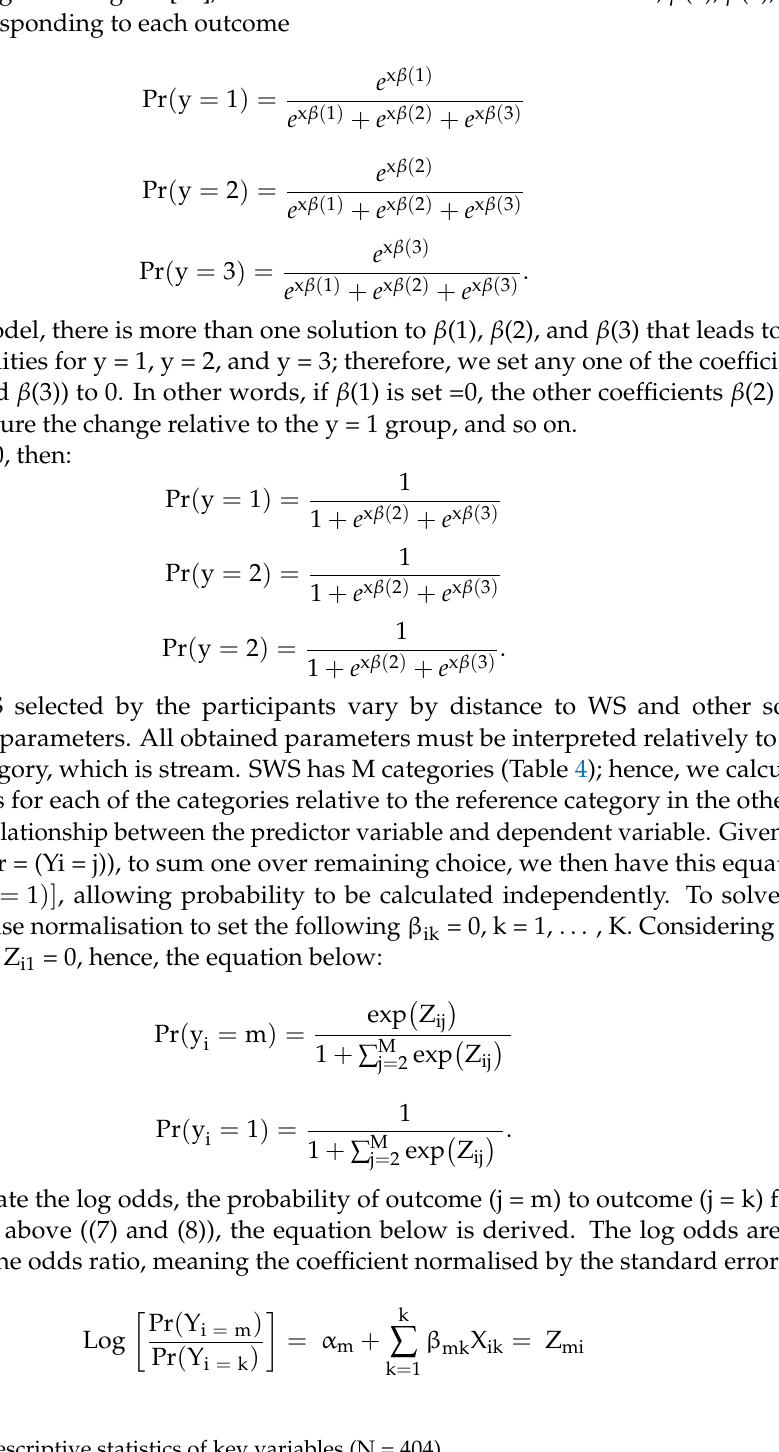
Table 4. Descriptive statistics of key variables (N =